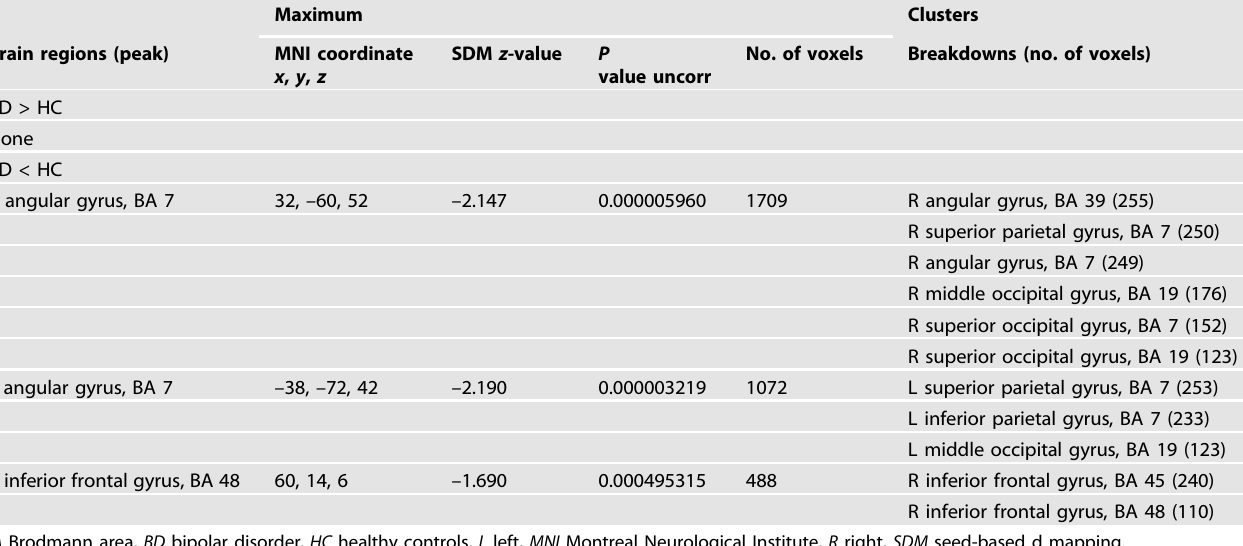
Table 2. Signi fi cant differences in brain activation between individuals with BD and